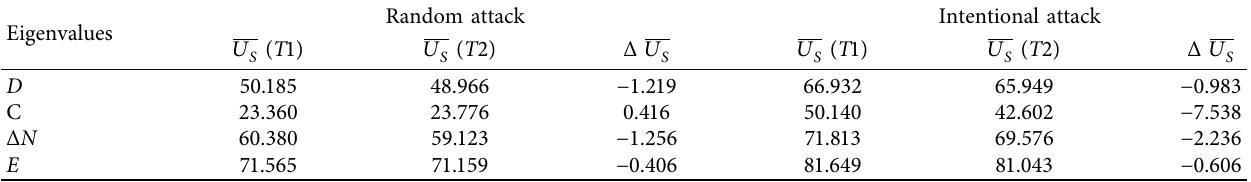
Table 5: Average rate of change in network eigenvalues.